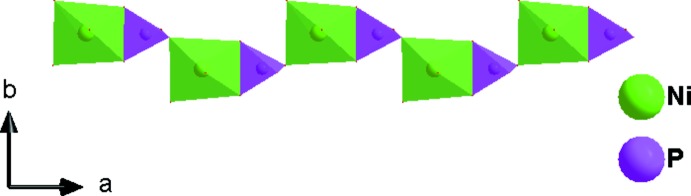
Corner- and edge-sharing [P1O4] tetra­hedra and [Ni1O6] octa­hedra forming a zigzag shape chain running parallel to [100]